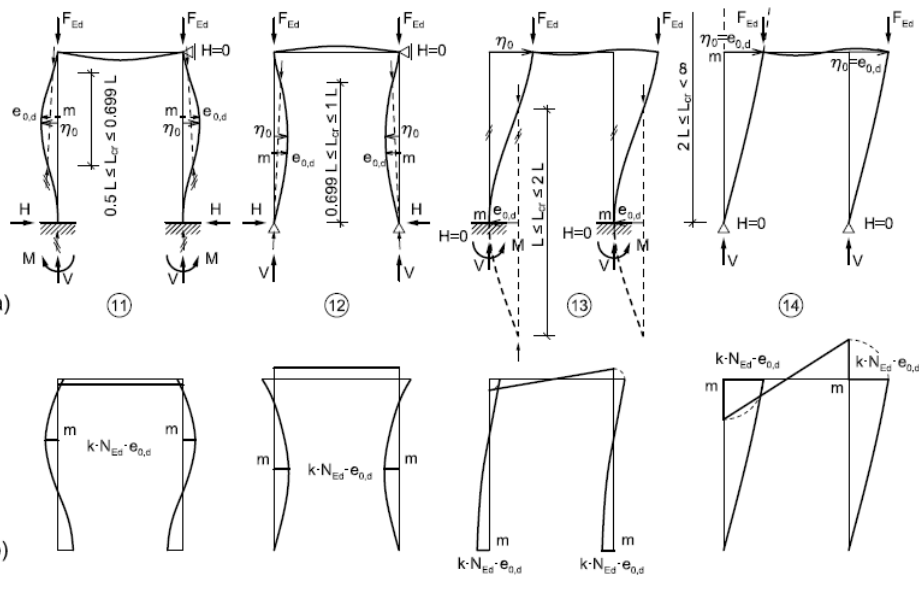
Figure 17. ( a ) UGLI imperfection and locations of 𝑒 (cid:2868),(cid:2914) and 𝜂 (cid:2868) ; ( b ) bending moment distributions and locations of maximum moment 𝑀 (cid:2889)(cid:2914)(cid:2893)(cid:2893) = 𝑘𝑀 (cid:2889)(cid:2914)(cid:2893) = 𝑘𝑁 (cid:2889)(cid:2914) 𝑒 (cid:2868),(cid:2914) in critical point m for cases No.11– No.14.